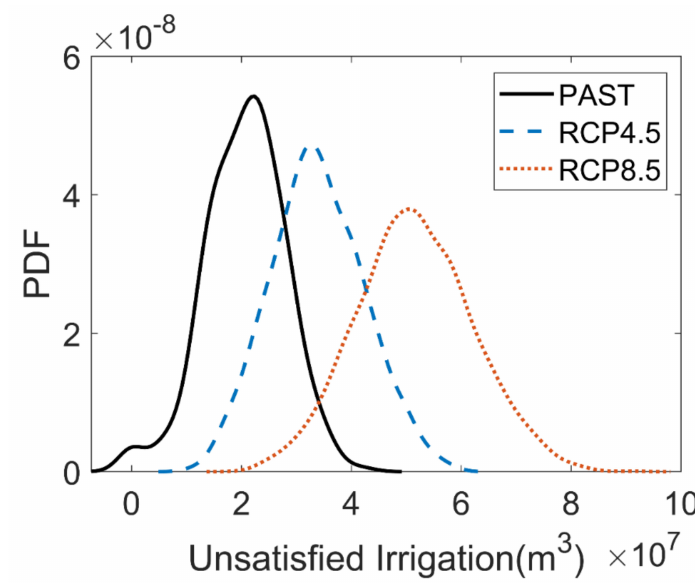
Figure 7. The annual amount of unsatisfied irrigation water under 3 different